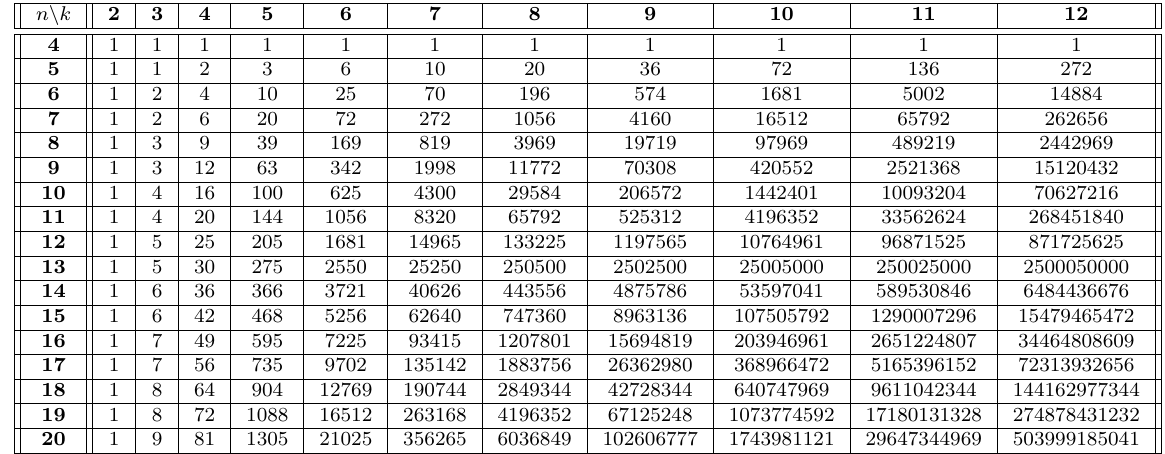
Table 2: Number on non-isomorphic k -cell C